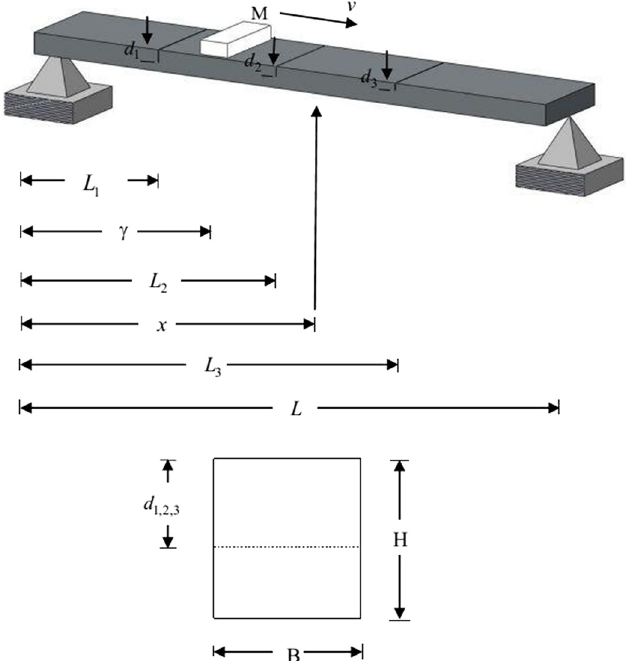
Fig. 1. Schematic presentation of cracked simply supported beam under traversing